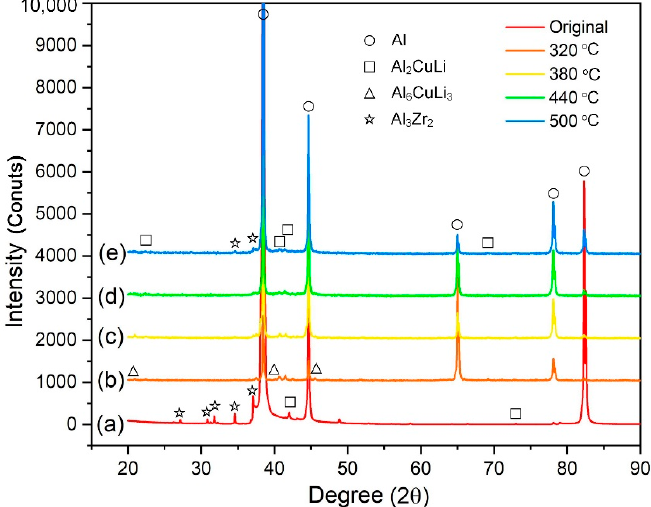
Figure 9. The XRD patterns the deformed alloys: ( a ) original sample, compressed sample: ( b ) 320 °C/0.001 s − 1 ; ( c ) 380 °C/0.001 s − 1 ; ( d ) 440 °C/0.001 s − 1 ; ( e ) 500 °C/0.001 s − 1 .